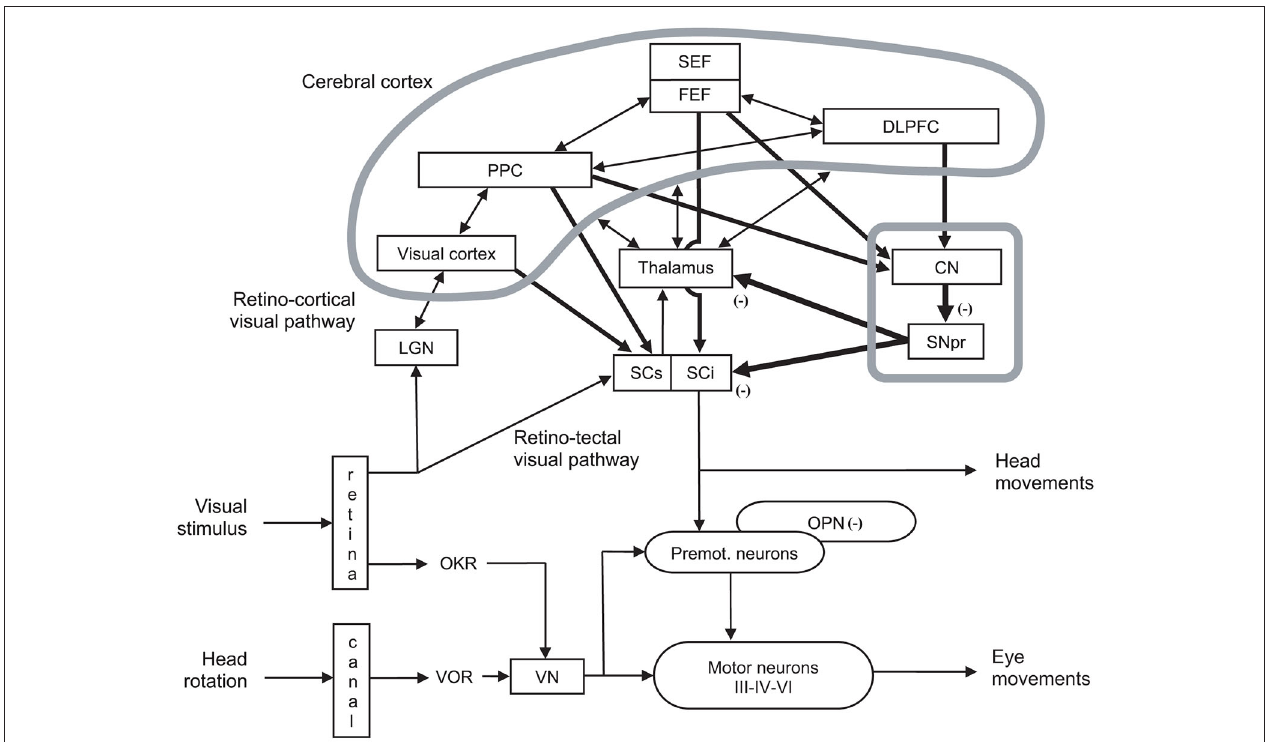
the sensory part (superficial layer) of superior colliculus (SCs), which directly activates SCi. In fine, eye movements are triggered by premotor (Premot.), which are under the inhibitory control of omnipause neurons (OPN). Premotor neurons activate motor neurons of oculomotor (III), trochlear (IV) and abducens (VI) nerves. Eye movements also interact with head movement (not developed). Other notations: DLPFC: dorsolateral prefrontal cortex; OKR: optokinetic response; VN: vestibular neuron; VOR: vestibulo-ocular reflex. Adapted from Hikosaka et al. (2000, p. 956, Figure